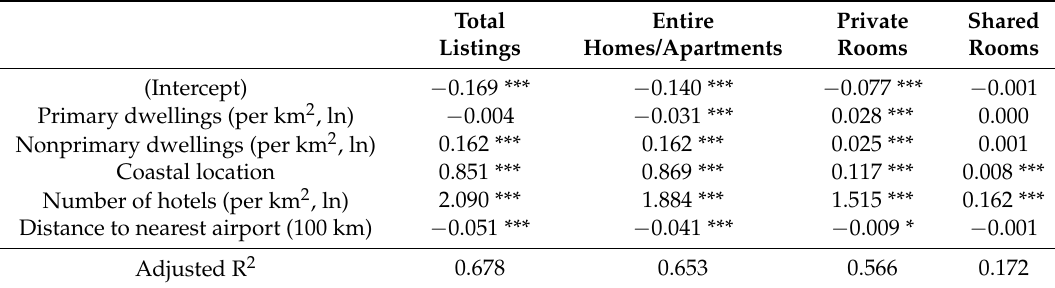
Table A5. Initial linear models for municipalities (N = 8124).